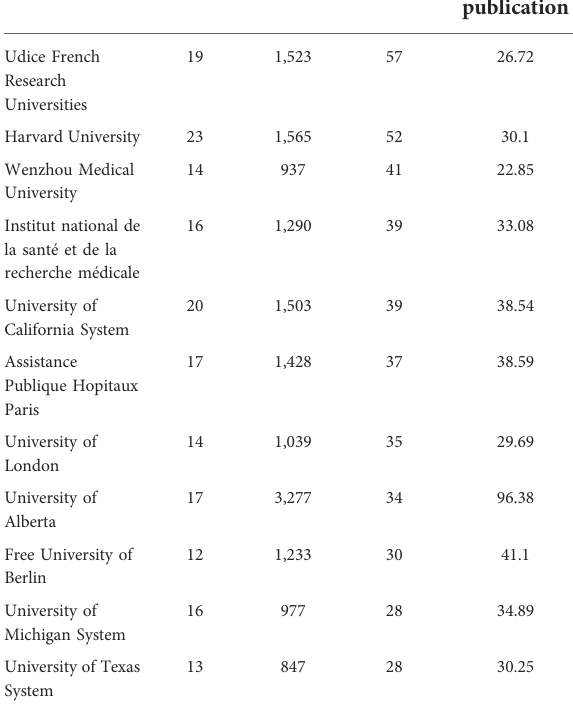
TABLE 2 The top 10 institutions with the largest number of publications on the relationship between sarcopenia and